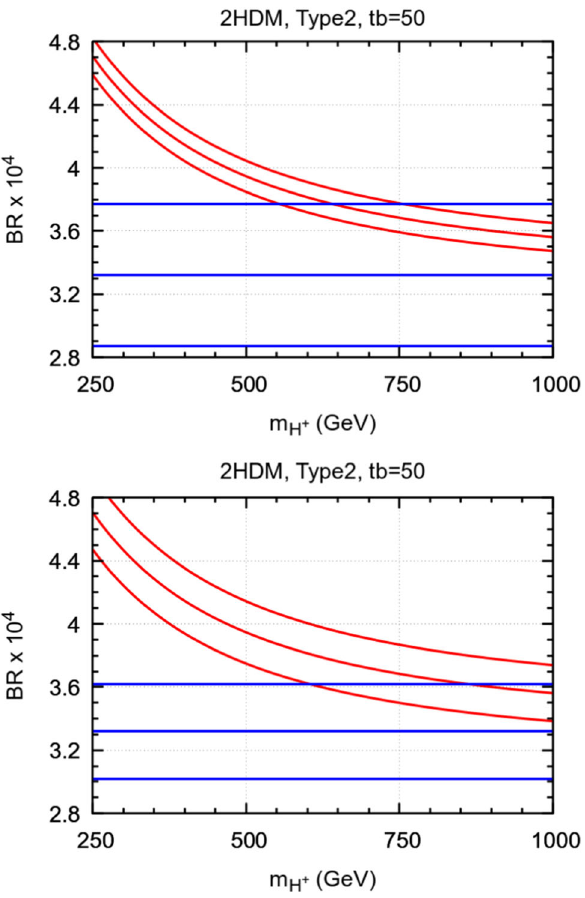
Fig. 1 BR( B → X s γ ) as a function of the charged scalar mass. Upper panel: The lines in blue represent the 3 σ experimental limits, and those in red to 2.5% error in the calculation. Lower panel: The lines in blue represent the 2 σ experimental limits, and those in red to 5% error in the calculation